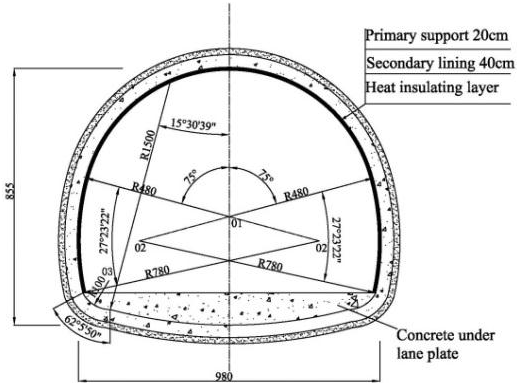
Figure 2. Cross-section of Dege tunnel (in cm).